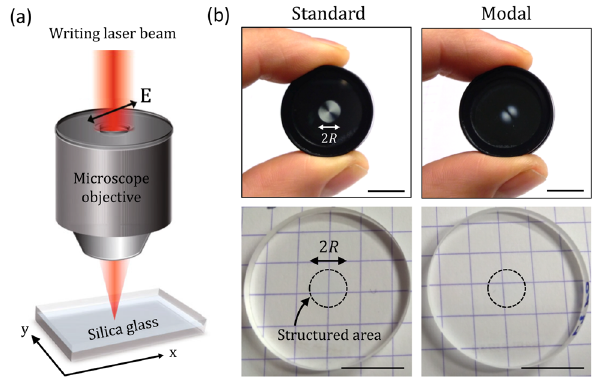
Figure 1: Main characteristics of the samples. (a) Sketch of the ultrafast laser writing of inside a slab of silica glass adapted from [11], where the double arrow refer to the orientation of the linearly polarized writing beam described by the electric field E . (b) Pictures of the standard [ l = 1] and modal [( l , p ) = (1 , 0)] vortex beam shapers observed in ambient light conditions through crossed linear polarizers (upper panels) and when placed on the top of a sheet of graph paper with 5 × 5 mm grid (bottom panels). The optical vortex shapers have a disk-shaped footprint of diameter 2 R = 6 mm and are embedded in a disk slab of diameter 1 inch and thickness 3 mm, typically at a 0.2 mm distance below the air/glass interface from which impinges the writing laser beam. Scale bar: 1